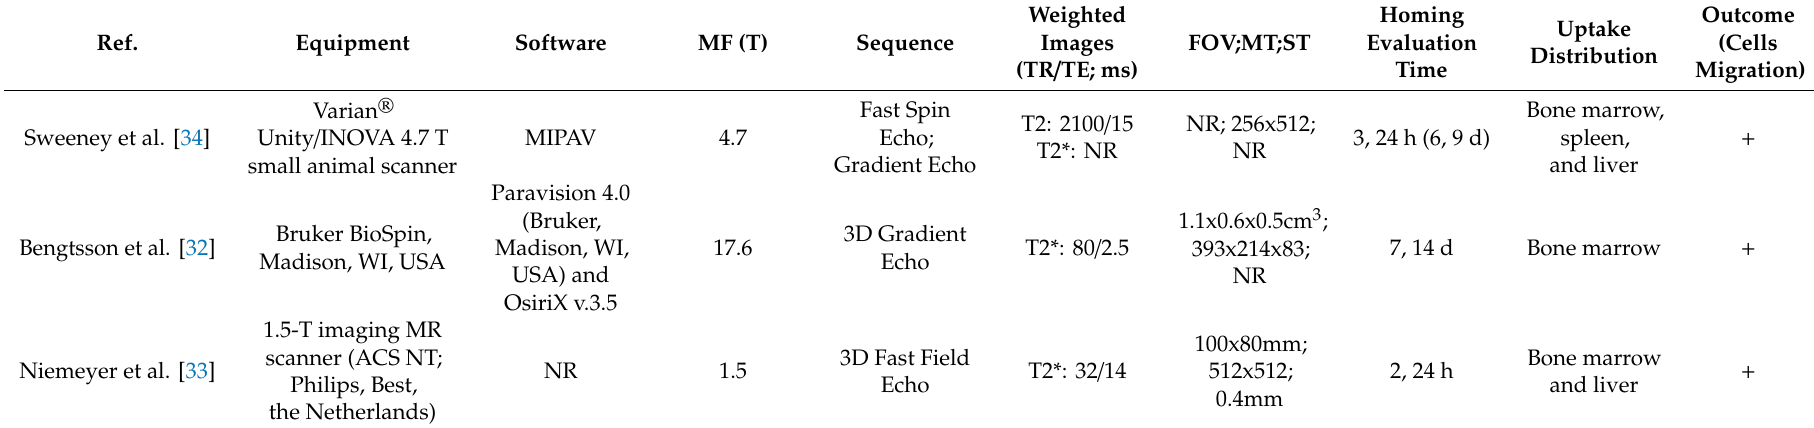
Table 10. HSC migration homing and tracking by magnetic resonance